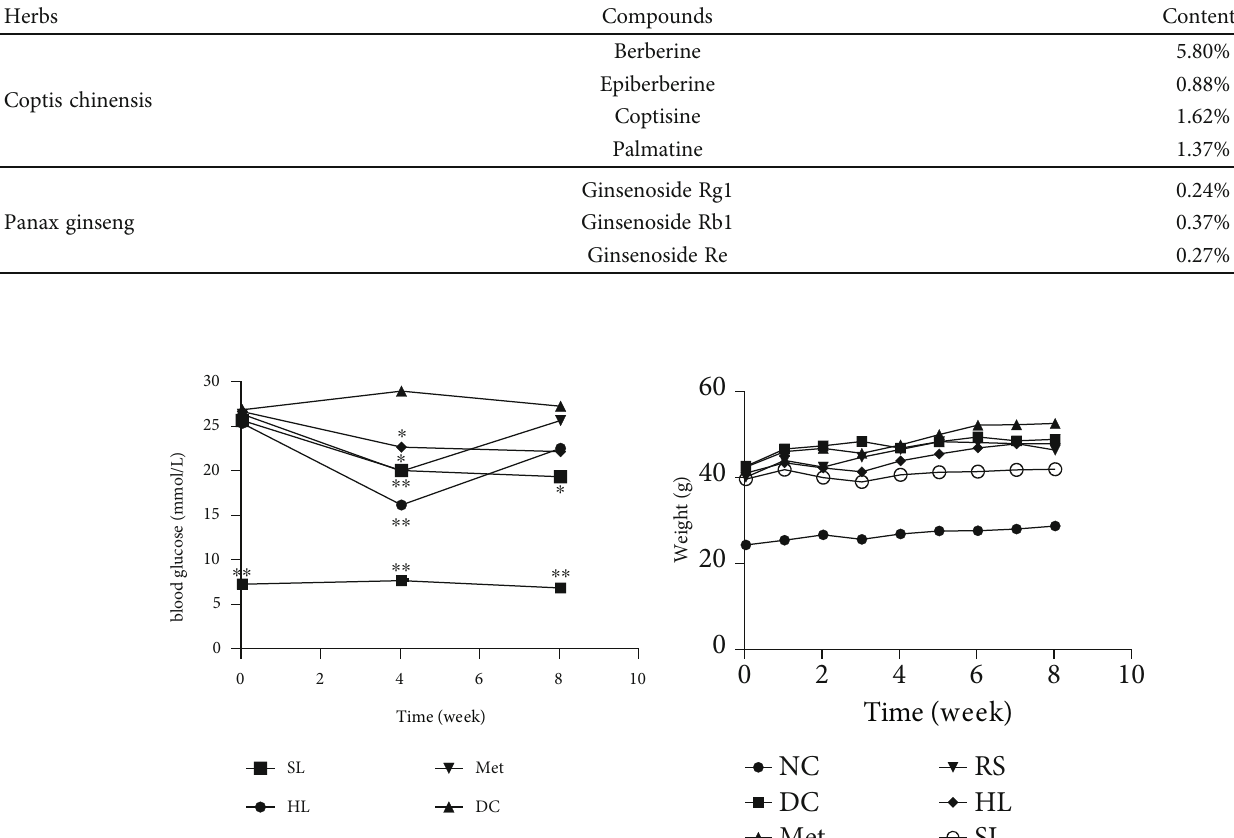
Table 1: Contents of the main identi fi ed compounds in SL